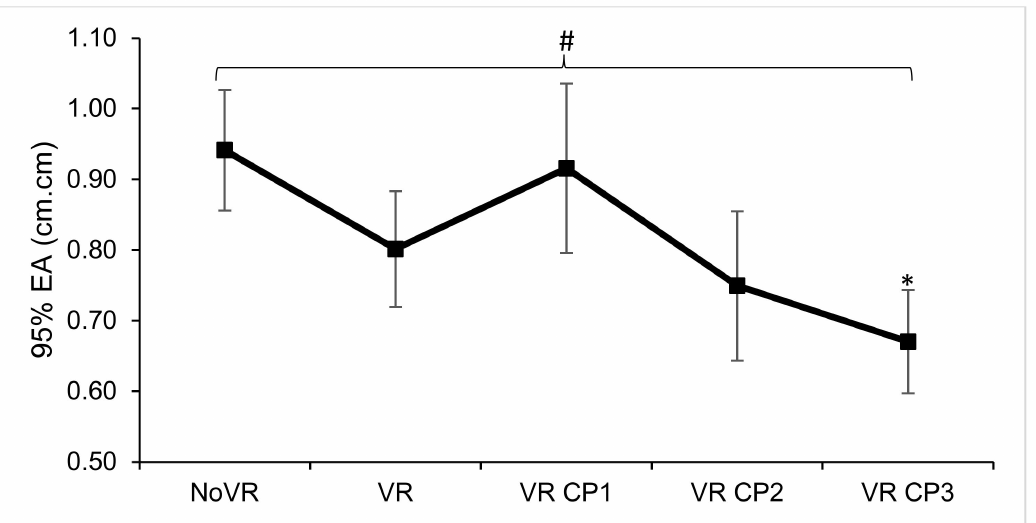
Figure 6. 95% ellipsoid area (EA) (cm 2 ) during upright bilateral stance with no virtual reality (NoVR), with virtual reality (VR), first trial in virtual environment with room walls closing in (VR CP1), second trial (VR CP2), and third trial (VR CP3). # represents main effect significance and * represents post-hoc pairwise comparison significance. Bars represent standard